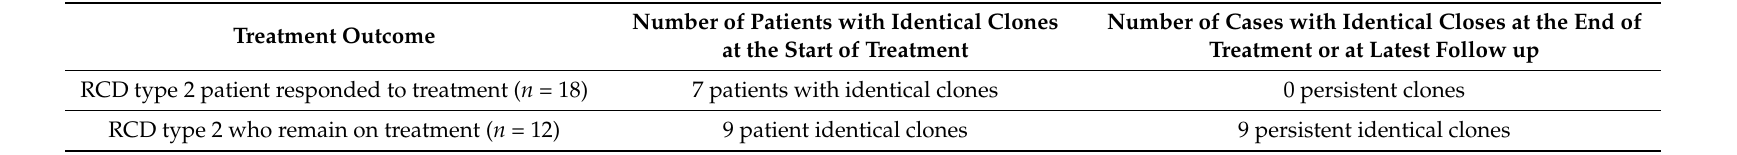
Table 3. Persistent identical clones observed at the start of treatment and at follow up.